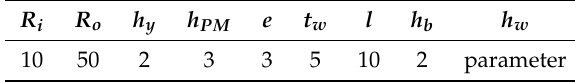
Figure 9. Study case: bearing topologies: ( a ) Topology 1; ( b ) Topology 2; and ( c ) Topology 3. Table 3. Study case: bearing dimensions